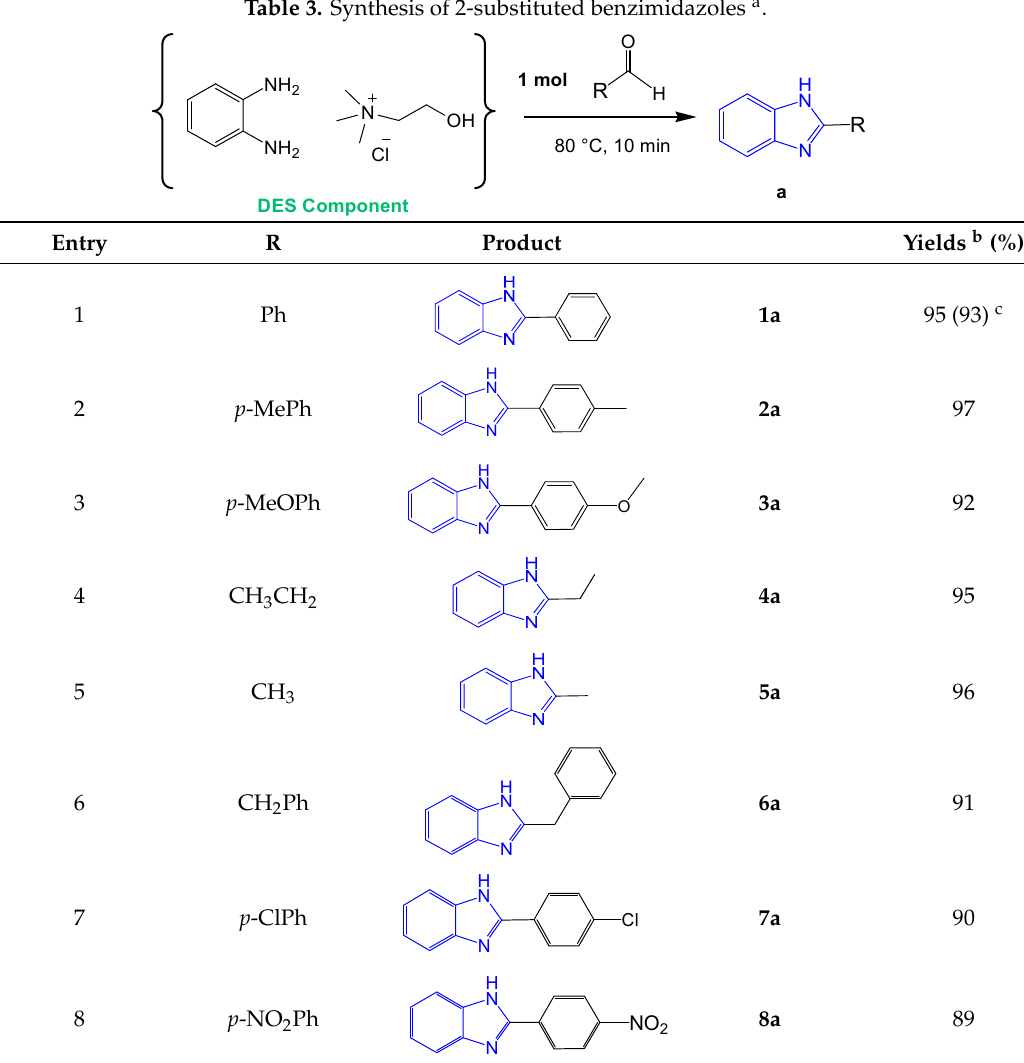
Table 3. Synthesis of 2-substituted benzimidazoles a .